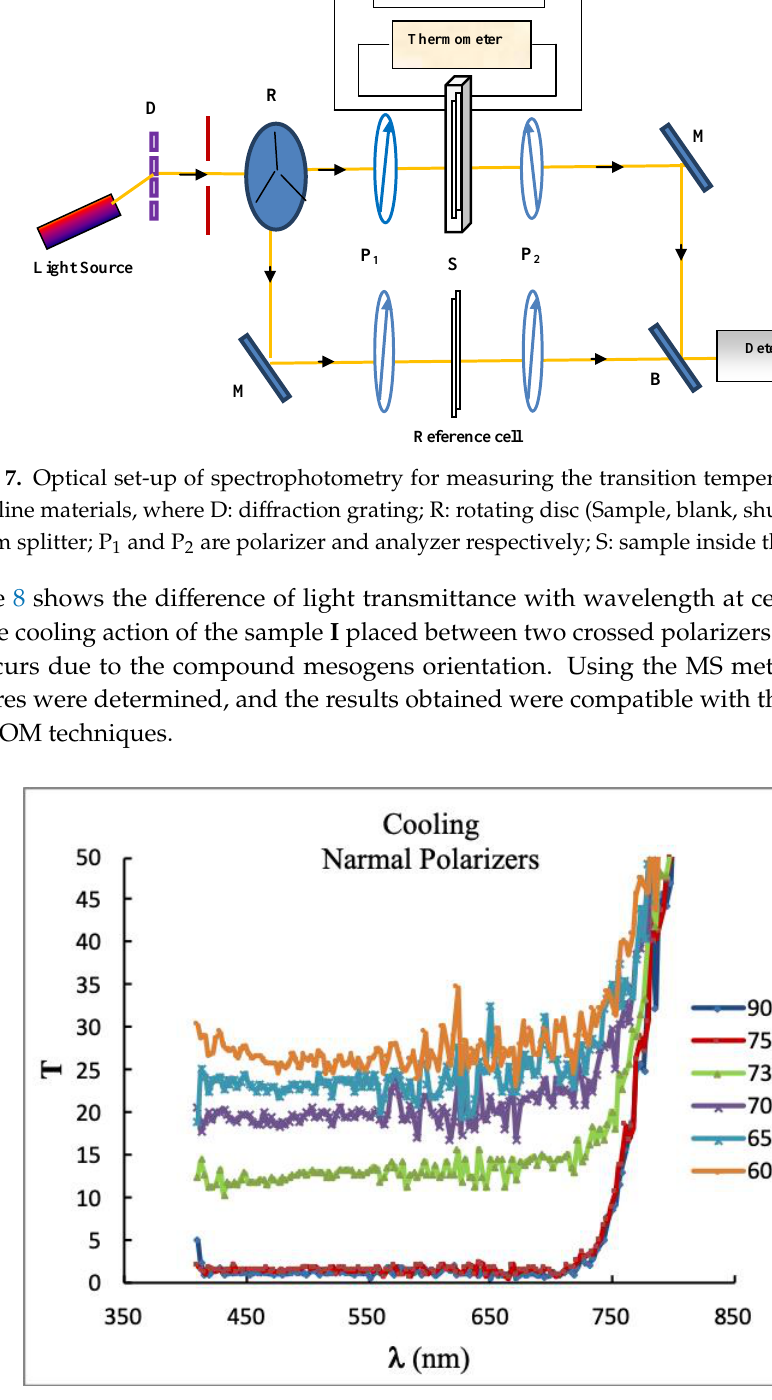
Figure 8. The variable transmittance with wavelength at certain temperatures for the prepared compound ( I) . Table 2. The birefringence ∆ n by using the modified spectrophotometer (MS), Abbe refractometer and interferometric techniques at 589.3 nm and temperature of 65 °C, ∆ n o is the birefringence at T = 0 °C and the material constant β for the investigated compound.